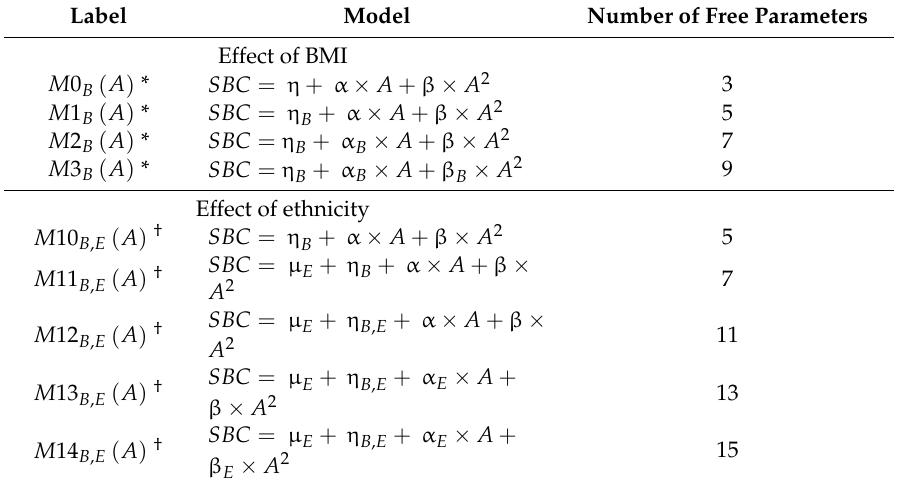
Table 3. Proposed parametric models for assessing the effect of BMI category and ethnicity, respectively, for a given gender and weight trend